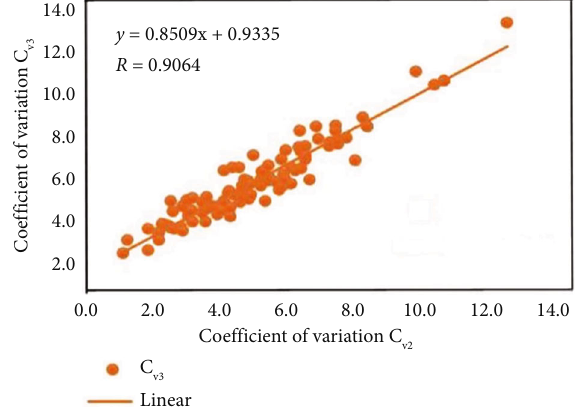
C v 2 vs. v 3 . Figure 10: Correlation between coe ffi cients of variation C C v 3 . Table 2: Correlation relationships of digital image